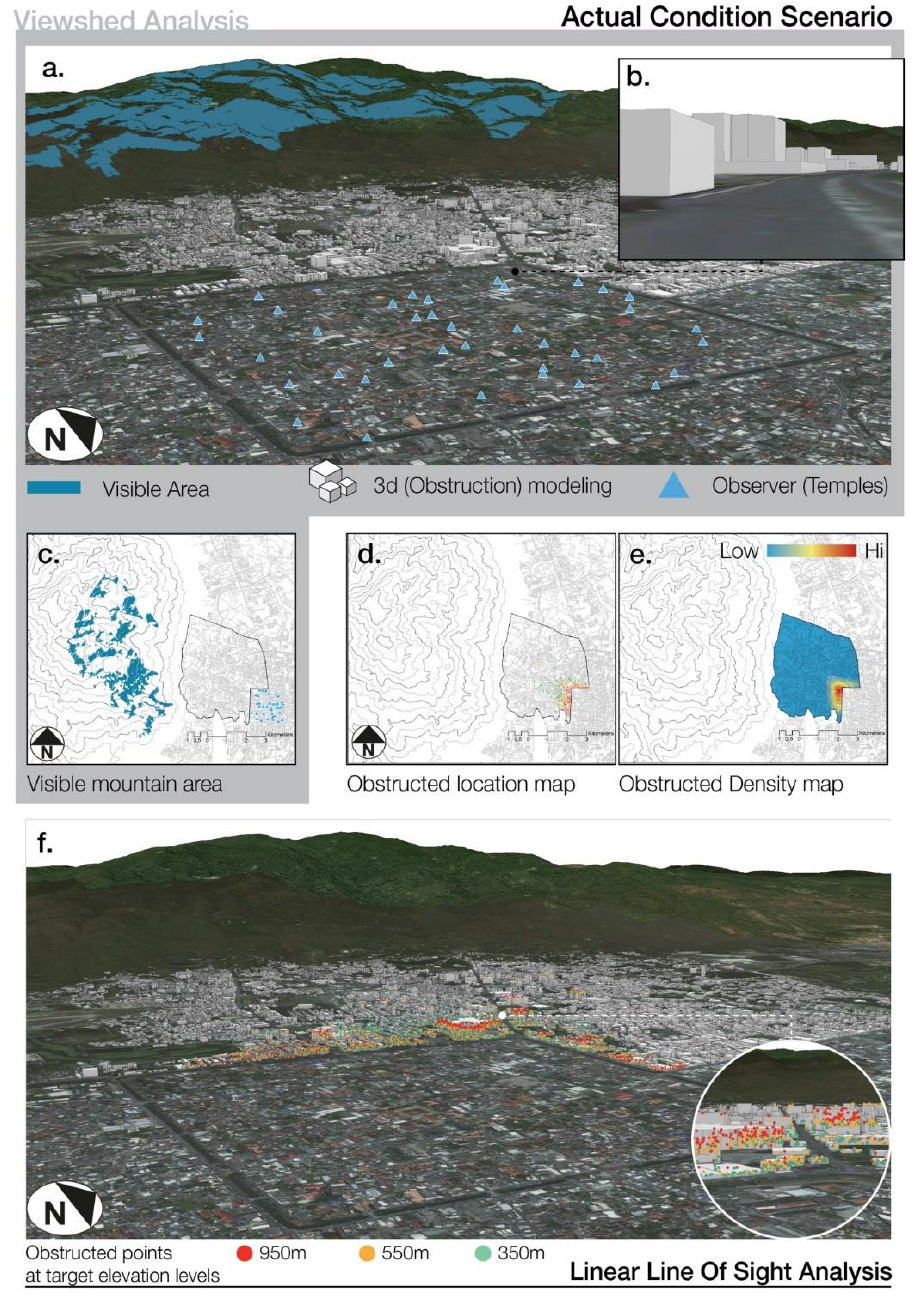
Figure 11. Results of the Actual Condition Scenario ( a ) Viewshed result in 3D ( b ) A sample view at human eye-level ( c ) Viewshed map ( d ) Obstructed location map ( e ) Obstructed density map ( f ) Obstructed locations at three elevation levels (Source: Authors).